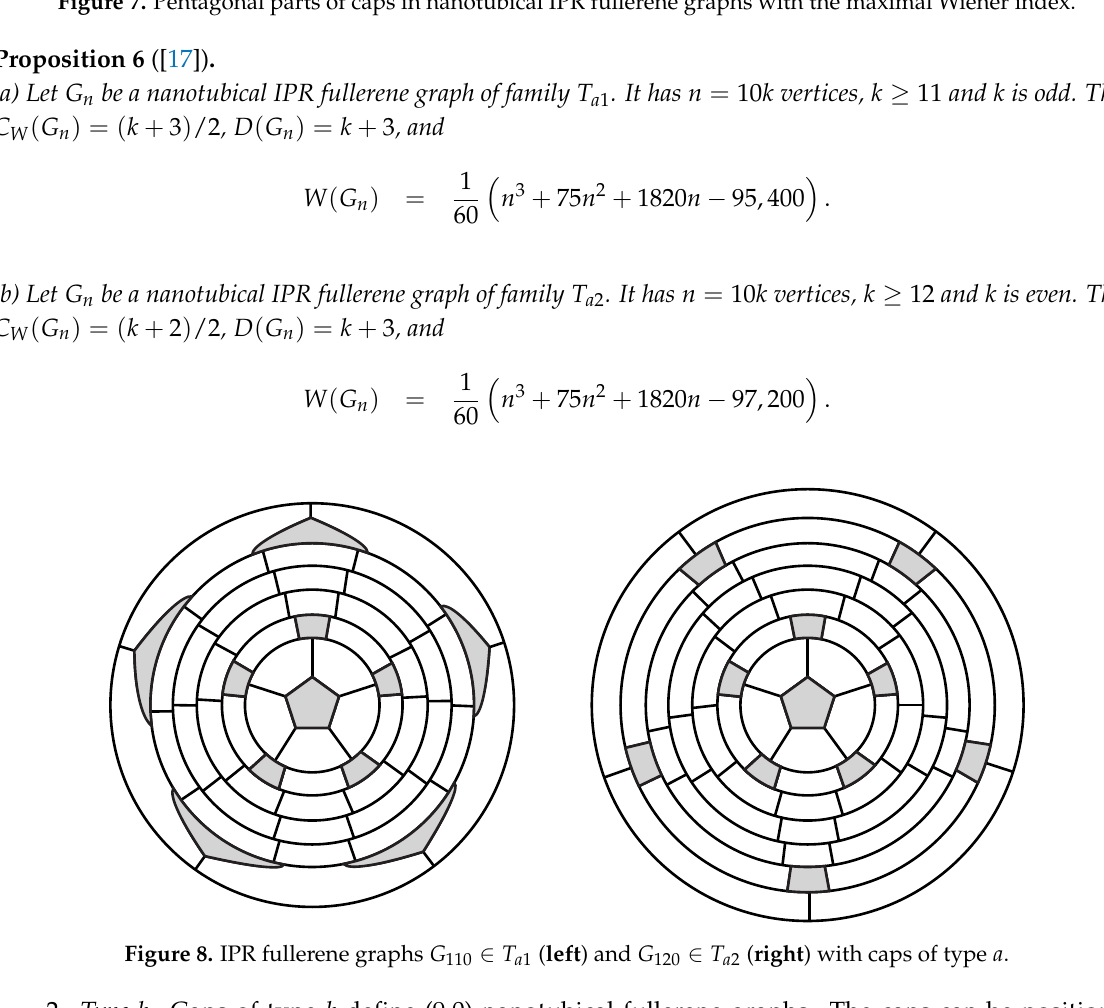
Figure 7. Pentagonal parts of caps in nanotubical IPR fullerene graphs with the maximal Wiener index.